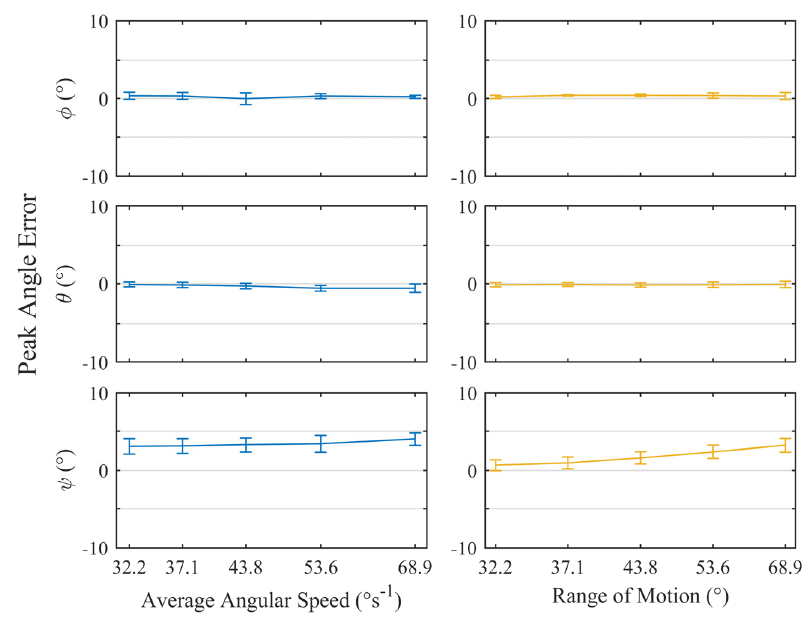
Figure 10. Plots of the mean angular error ± standard deviation for all peaks across n = 5 trackers